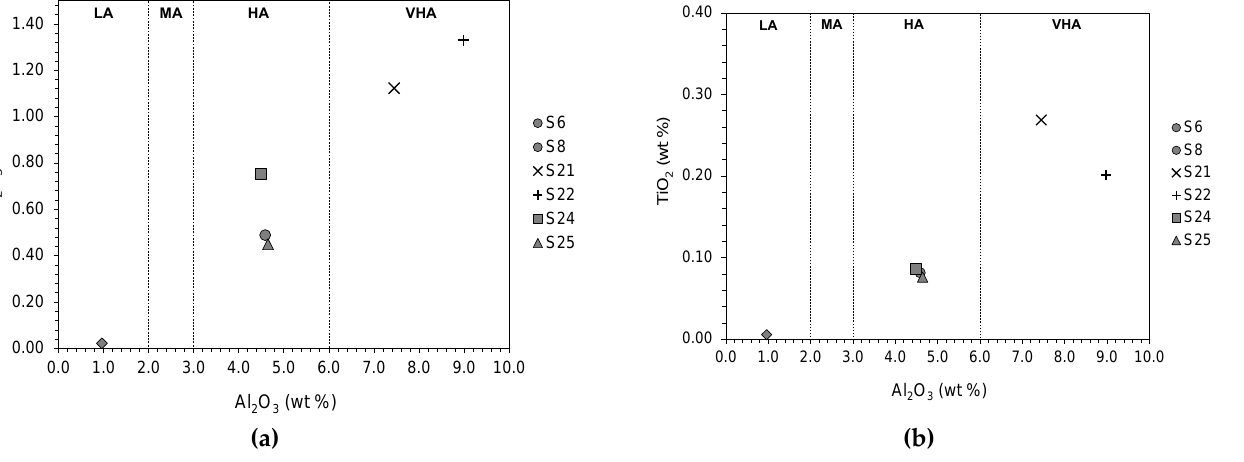
Figure 3. Binary charts of ( a ) alumina vs. iron oxide and ( b ) alumina vs. iron oxide in weight percent of oxides. The vertical lines indicate the proposed separation between low alumina (LA), medium alumina (MA), high alumina (HA) and very high alumina (VHA) contents [17].